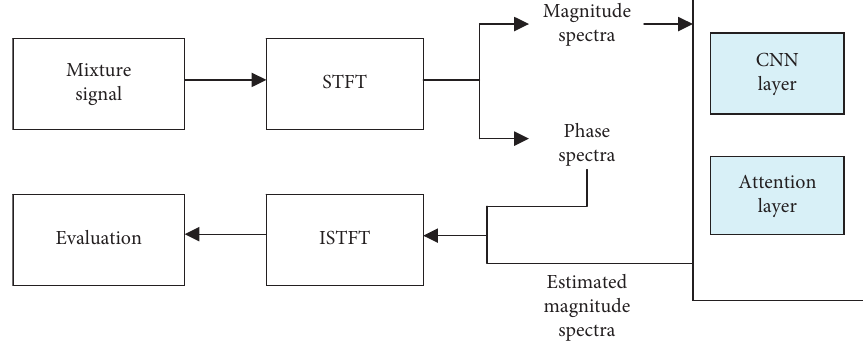
Figure 1: The modeling of speech